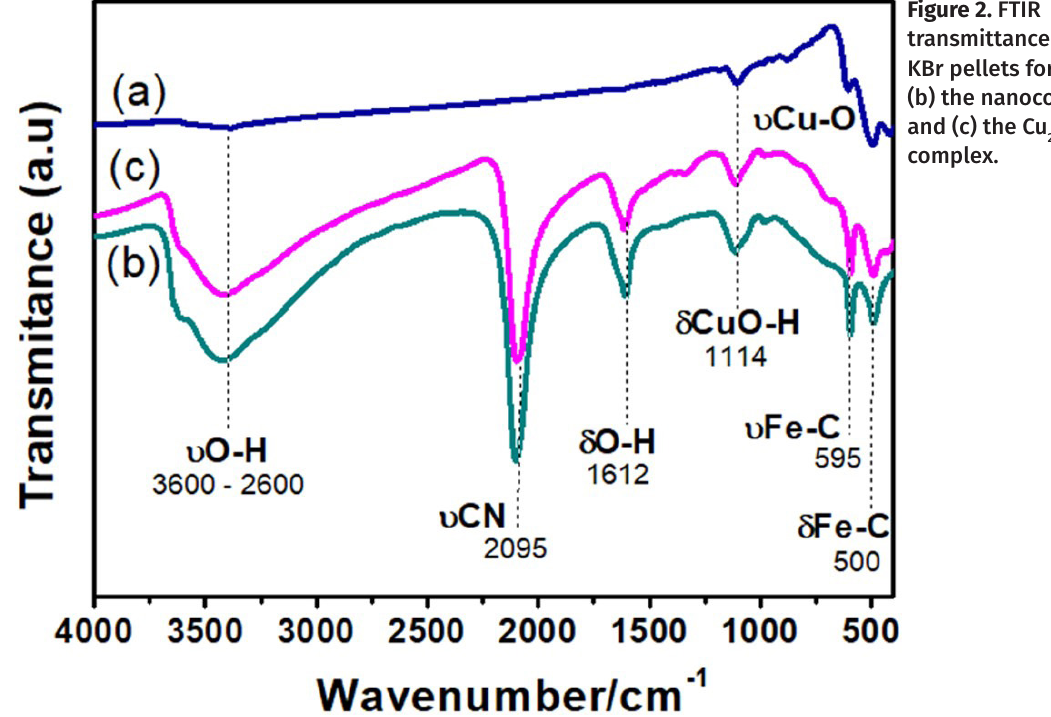
Figure 2. FTIR transmittance spectra in KBr pellets for (a) CuO, (b) the nanocomposite, and (c) the Cu